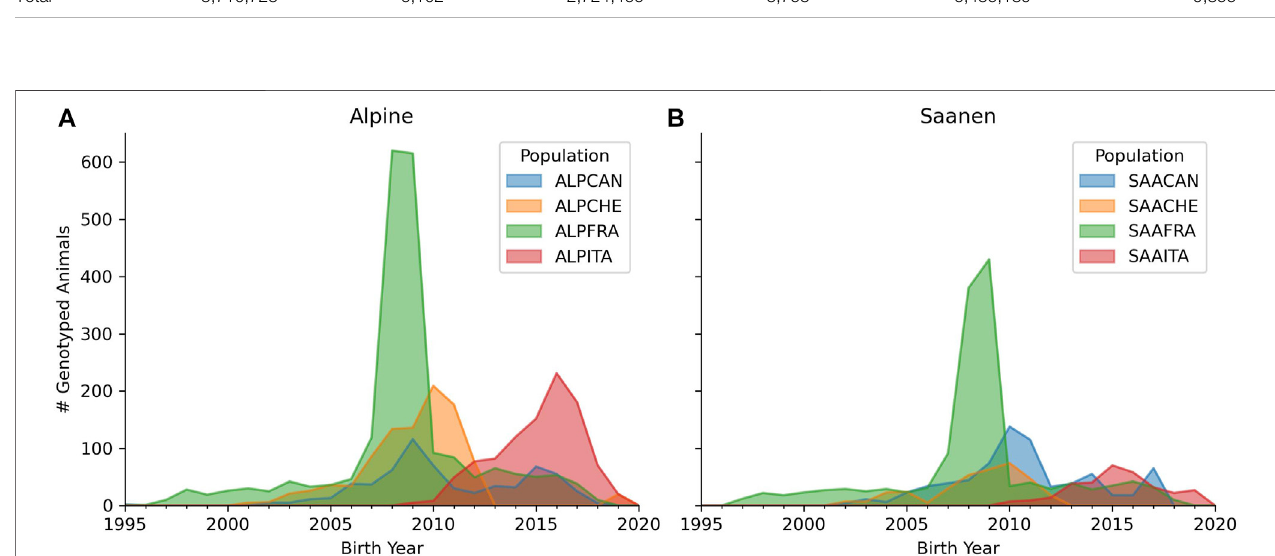
FIGURE1| NumberofgenotypedanimalsaccordingtothebirthyearforAlpine (A) andSaanen (B) breedsineachcountry(France,Canada,Italy,andSwitzerland). The legend represents the breed (ALP for Alpine and SAA for Saanen) and country (CAN for Canada, CHE for Switzerland, FRA for France, and ITA for Italy).